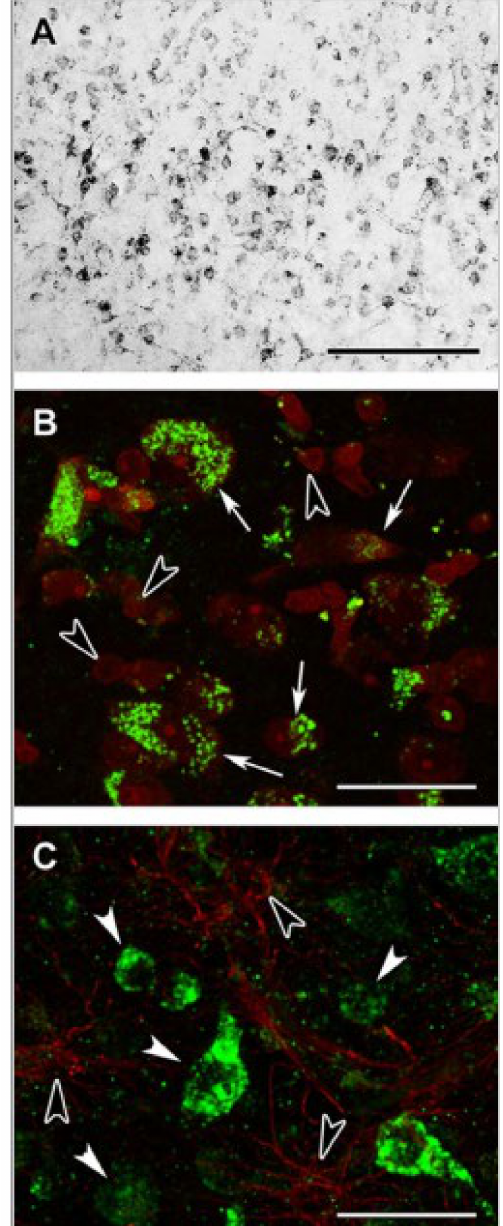
Figure 4. DLST (Dihydrolipoyllysine-residue succinyltransferase, E2 subunit of KGDGC) im- munolabeling in the human cerebral cortex in relation to neuronal and glial markers. ( A ): DLST- immunoreactive (DLST-ir) cells are present in the cerebral cortex, with higher density in the deep layers. ( B ): DLST (green) and fluorescent Nissl staining (red) show that many cells are double-labeled in the cerebral cortex. Arrows point to double-labeled neurons, while black arrowheads point to single-labeled, DLST-immunonegative cells. Note the dot-like distribution of DLST immunolabeling in the double-labeled neurons. ( C ): A cerebral cortical section double-labeled with DLST (green) and the established astrocyte marker glial fibrillary acidic protein (GFAP; red) to show the lack of double- labeling, suggesting that GFAP-expressing astrocytes are devoid of DLST. White arrowheads point to single-labeled (DLST-ir) neurons; black arrowheads point to single-labeled (GFAP-ir) astrocytes. Scale bars = 300 µ m for ( A ), and 30 µ m for ( B , C ). (Adapted from [100] under the terms of the Creative Commons CC BY